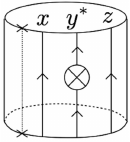
Figure 17 . The transition amplitude for the above cylinder with a cross-cap is a linear map from to V , which is given by A V ( x ⊗ y ) ⊗ z ( x ⊗ y ∗ ) ⊗ z